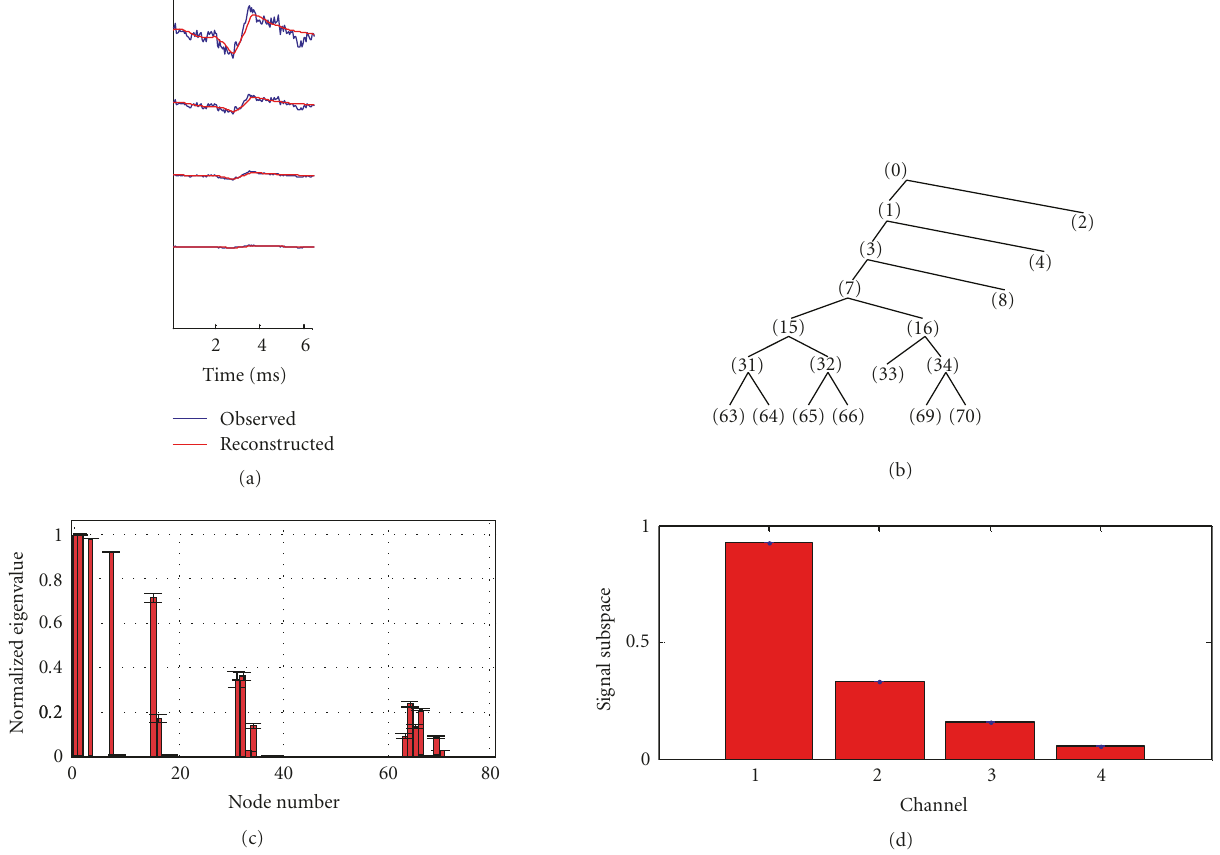
Figure 5: (a) Single realization of a signal from source 1 along a 4-electrode array before and after best basis reconstruction (SNR = 4dB and 10.8 dB, resp.). (b) Characteristic best basis wavelet packet tree (wavelet basis used was symlet of order 4). (c) Feature vector comprising sample mean of λ l 1 for 200 realizations (standard deviation is shown as error bars). (d) Sample mean of the principal eigenvector u l 1 across best tree nodes for the realization in